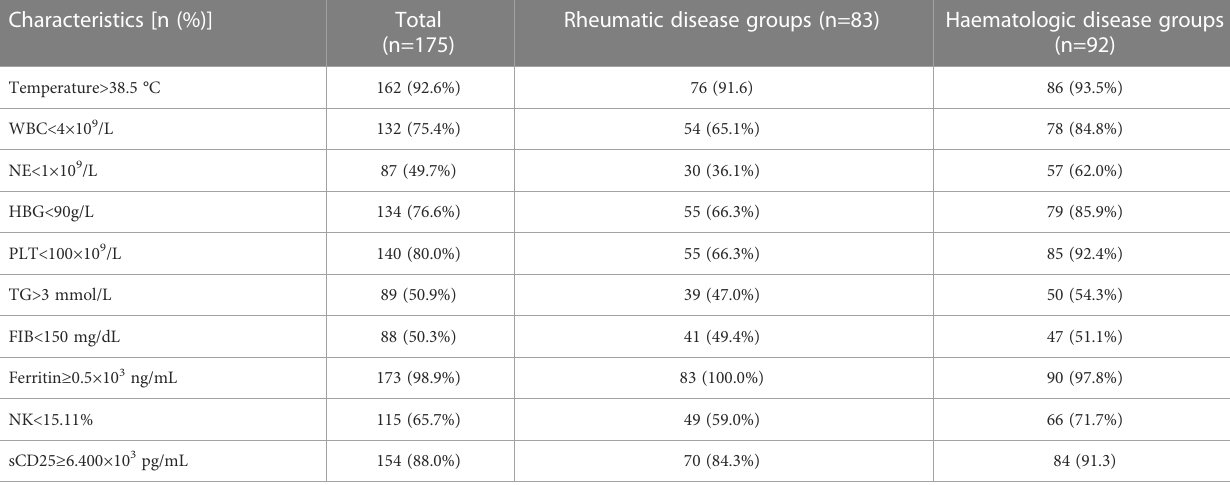
TABLE 2 Laboratory fi ndings and the ratios in rheumatic and haematologic disease cohorts. Characteristics [n